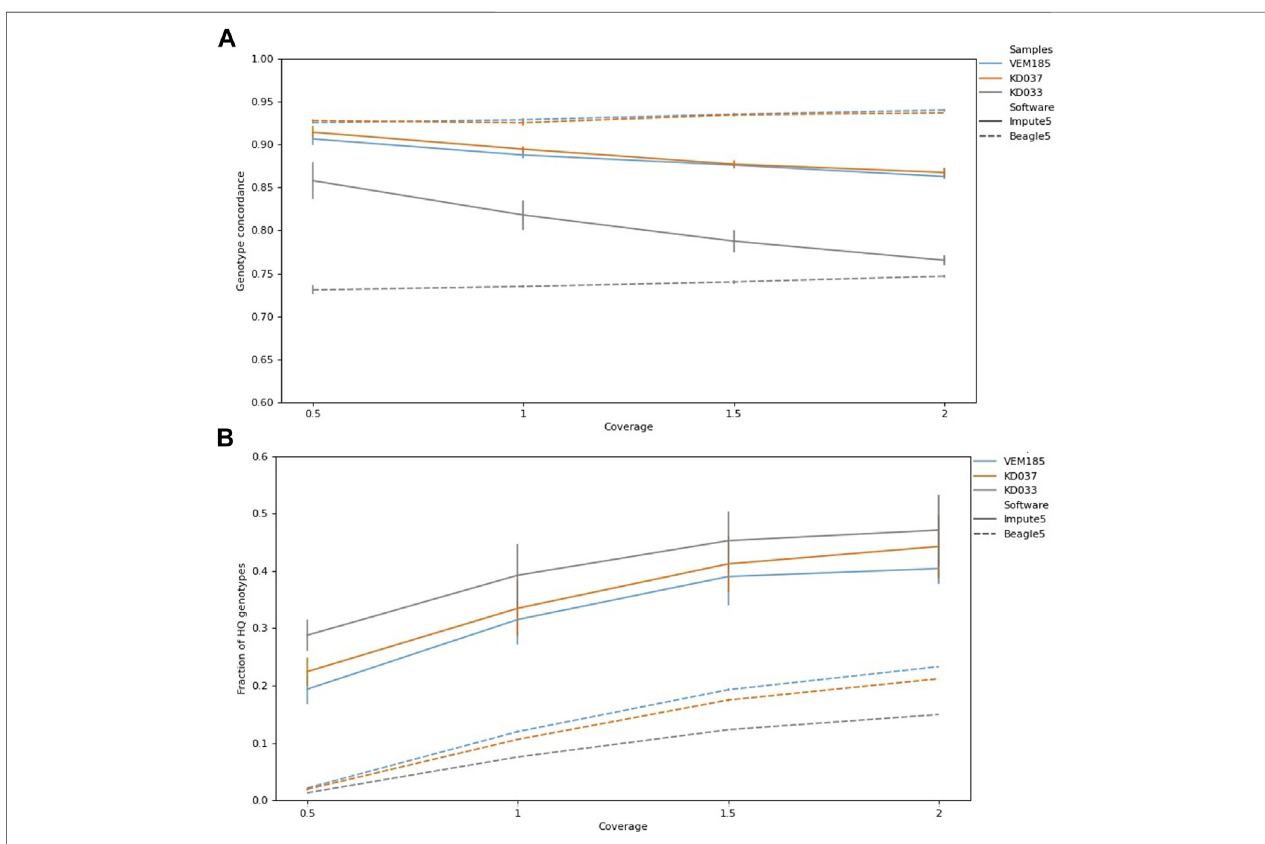
FIGURE4| Genotypeconcordanceandfractionofhigh-quality(HQ) genotypes(totalHQgenotypes:VEM185:4,701,683,KD037:4,531,126,KD033,3,887,848) of imputed samples for different levels of coverage for Impute5 and Beagle5. Imputation was performed using IMP1 and IMP2. Bars are standard errors. Genotype concordance (A) , Fraction of HQ genotypes (B)